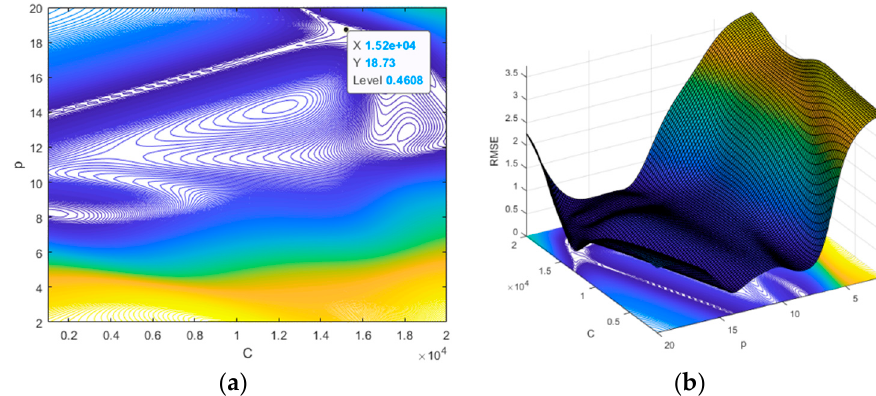
Figure 17. The 2D and 3D plots for the optimized parameters.